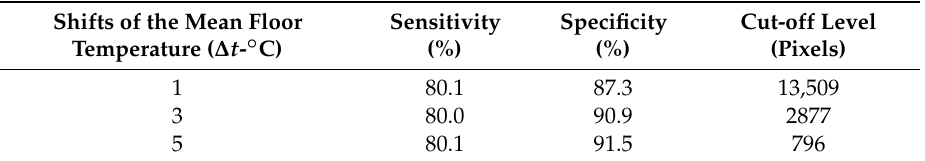
Table 2. Detection performances, reached during the setup procedure (step A), reported for each mean temperature shift investigated (i.e., 1, 3, and 5 ◦ C). Performances are shown in the table in terms of sensitivity and specificity. Furthermore, the corresponding cutoff level, in terms of number of colored pixels, that allows to classified a multiple occupation of the nest is also reported.